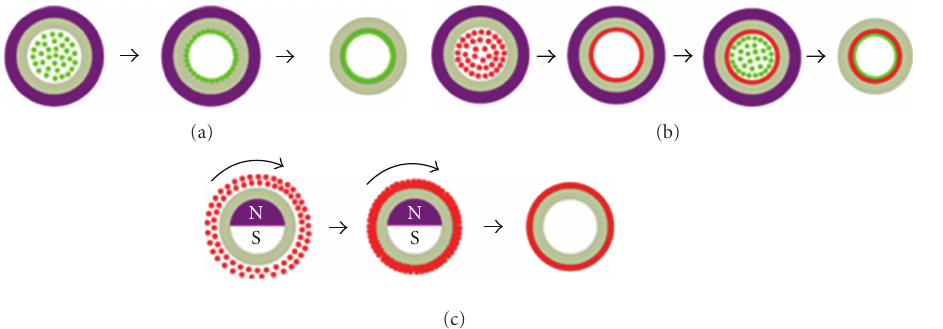
Figure 4: Magnetic-forces-driven vascular tissue engineering. The schematic illustrations shown above present three possible variations of magnetic-driven vascular tissue engineering, depending on the cells used and the placement of the vascular sca ff old. In the first arrangement (a), the magnet (purple) is placed outside of the vascular sca ff old and cells labeled with magnetic nanoparticles (green) are placed into the lumen. The magnet force causes the endothelial cells to adhere to and spread on the luminal surface of the vascular sca ff old with the subsequent formation of a continuous endothelial monolayer. The second variation (b) is similar to the previous in that the magnet (purple) is placed outside of the sca ff old (grey), but smooth muscle (red) and endothelial cells (green), both labeled with magnetic nanoparticles, are sequentially placed into the lumen for rapid adhesion and cellularization. In the third variation (c), the magnet (purple) is placed inside the vascular sca ff old (grey) and smooth muscle cells labeled with magnetic nanoparticles (red) are placed outside of the sca ff old. Rotation of the magnet enables the cell attachment with the subsequent formation of a concentric layer of smooth muscle cells on the external surface of the vascular sca ff old. Endothelization of the internal luminal surface can then be achieved as described in first variation.